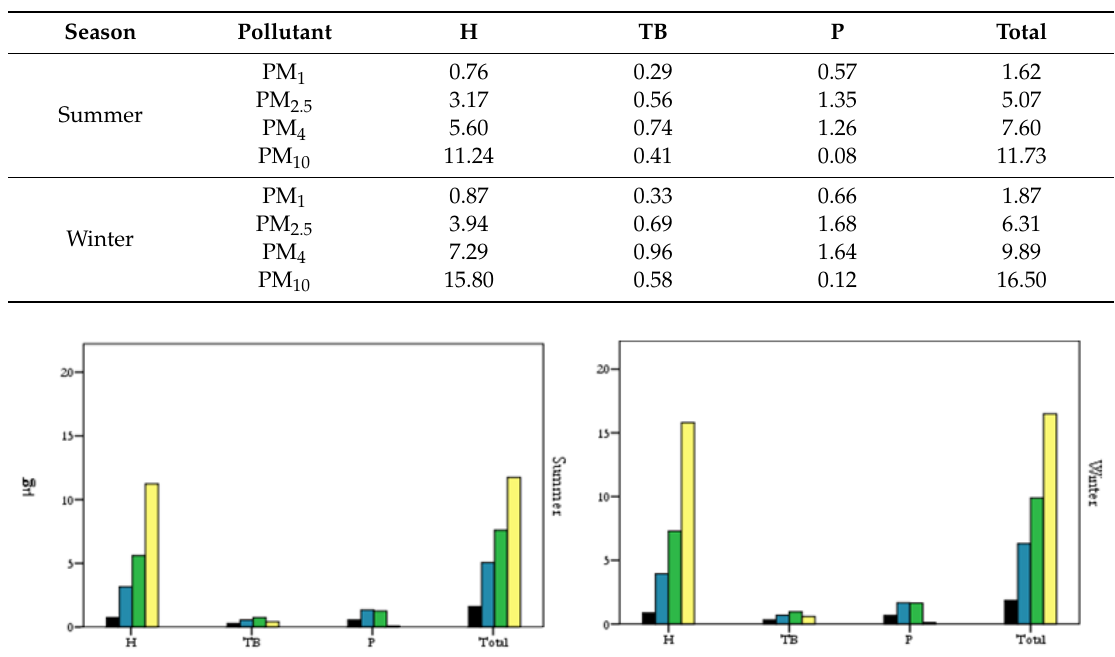
Table 2. Particulate matter (PM) mass values ( µ g) deposited in the respiratory tract during the monitoring period (8:00 a.m. to 3:00 p.m.) (sections: H: head; TB: tracheobronchial; P: pulmonary; total: H + TB + P).